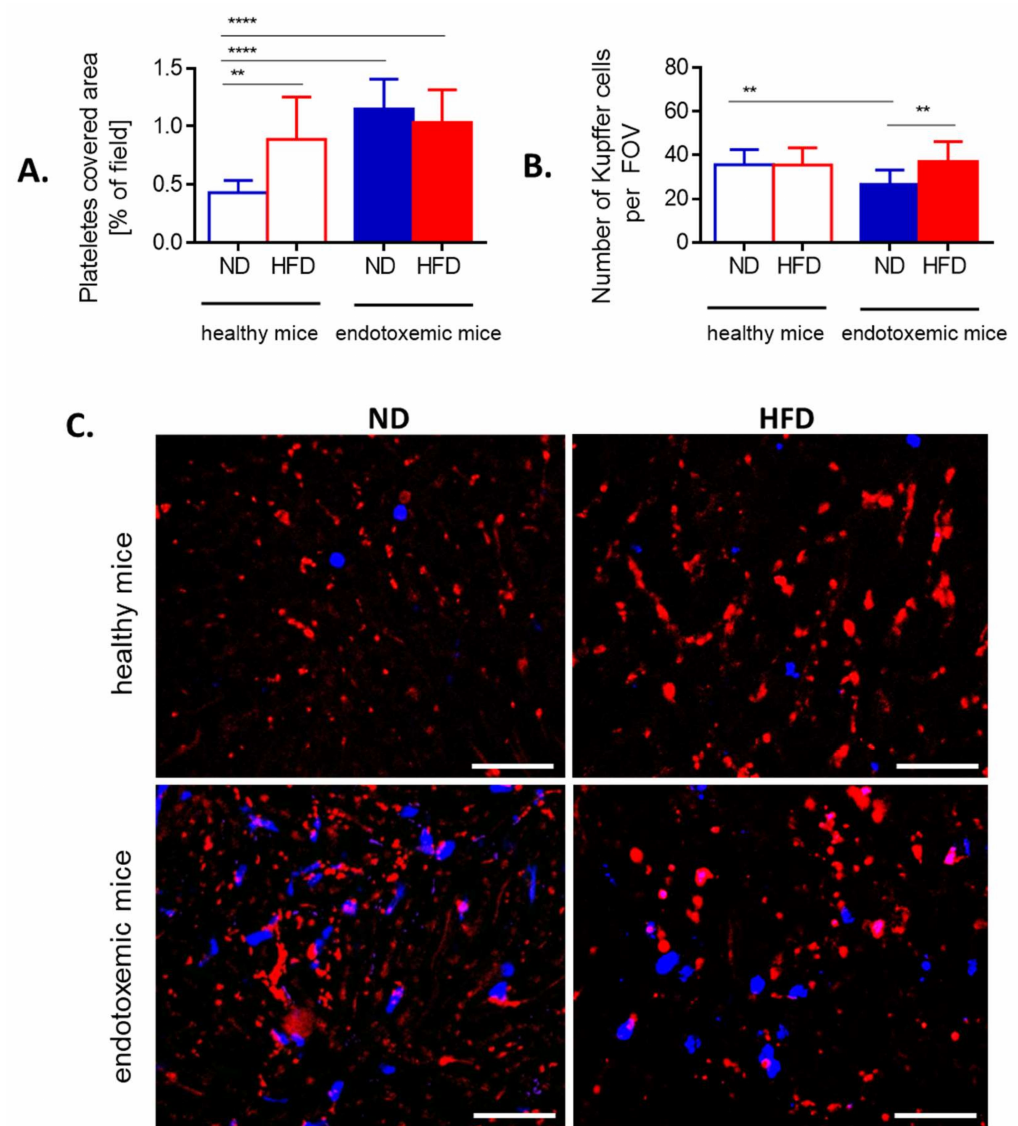
Figure 6. Presence of platelets and Kupffer cells in liver sinusoids of lean (ND) and obese (HFD) mice. ( A ) Area covered by platelets is expressed as percentage of covered area (as calculated by ImageJ v1.53a), and ( B ) Kupffer cells were counted per field of view (FOV) on acquired images. ( C ) Representative images of area covered by platelets (red) and localization of neutrophils (blue). The scale bar indicates 50 µ m. Asterisks indicate significant differences using unpaired two-tailed Student’s t -test (** p ≤ 0.01, **** p ≤ 0.0001). Data are shown as mean ± s.d.; n ≥ 3 per